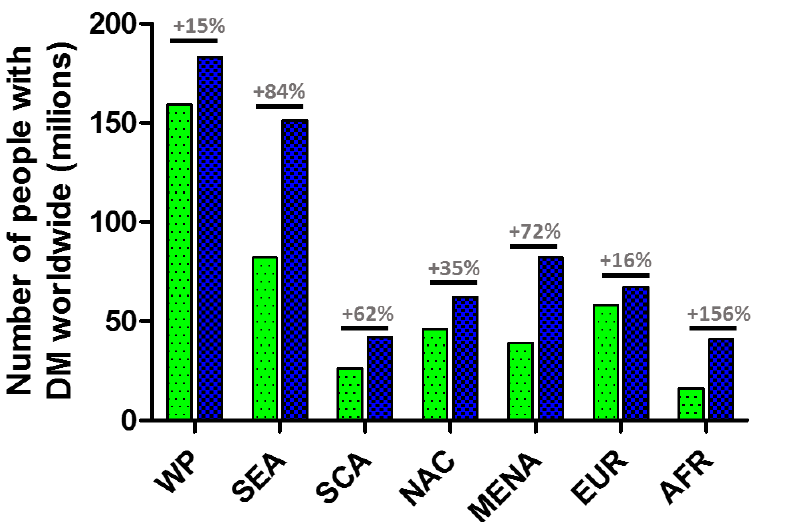
Figure 1. Number of people (millions) aged 20–79 years old with diabetes mellitus DM estimated by IDF, 2017 and 2045. (IDF = International Diabetes Federation, AFR = Africa, EUR = Europe, MENA = Middle East and North America, NAC = North America and Caribbean, SCA = South and Central America, SEA = South East Asia, WP = Western Pacific) [1].